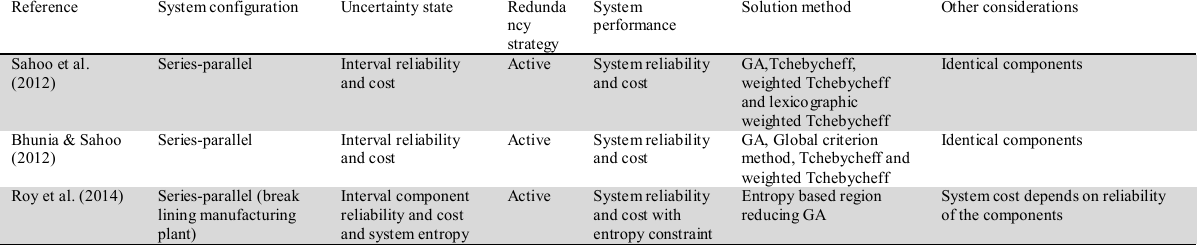
Redundancy allocation under interval uncertainty (Multi-objective Problems)